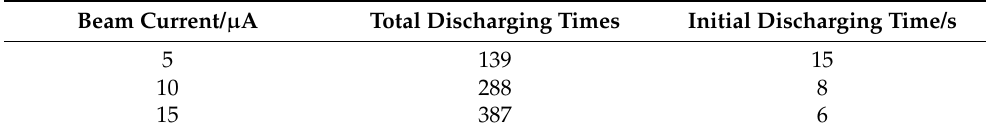
Table 4. Statistical results of ESD characteristics of PI within 20 min under 0.3 MeV electron radiation.